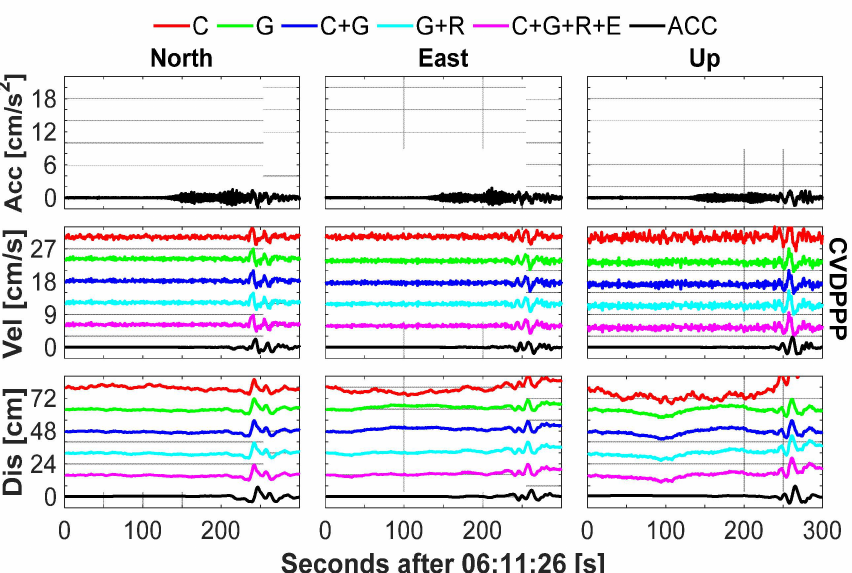
Figure 9. Acceleration, velocity, and displacement time series based on constant veloc- ity (CV) dynamic PPP (CVDPPP) for BDS, GPS, BDS + GPS, GPS + GLONASS and BDS + GPS + GLONASS + Galileo four system during 300 s after UTC 06:11:26